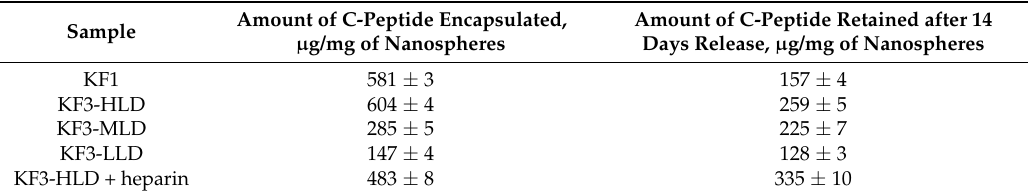
Table 5. Formulations applied for C-peptide release study.